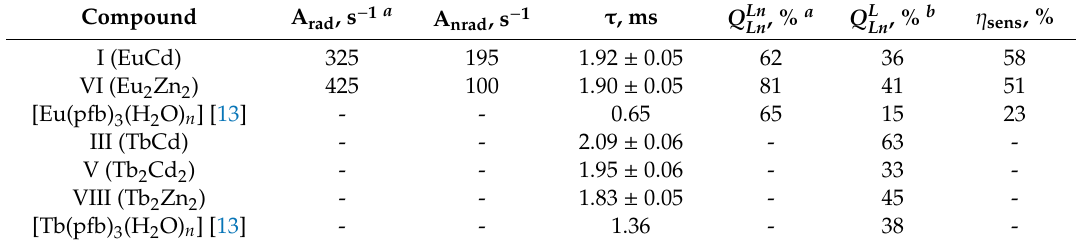
, % a Q L , % b η sens , % Ln Ln